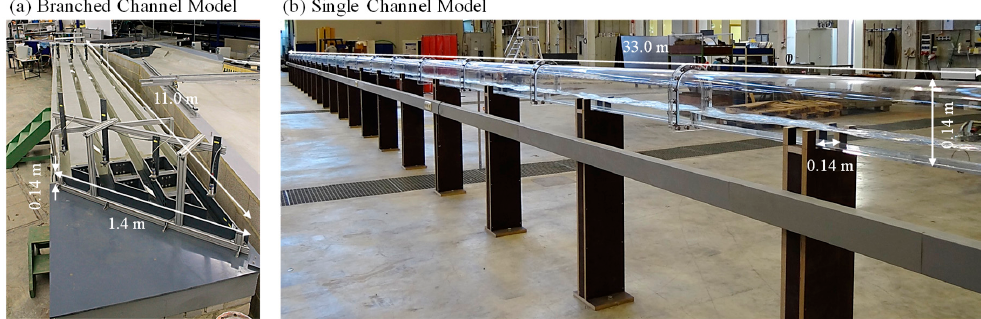
Figure 3. Photographs of the branched channel model ( a ) and the single channel model ( b ) at the Laboratory of the Institute of Hydraulic Engineering and Water Resources Management at RWTH Aachen University.